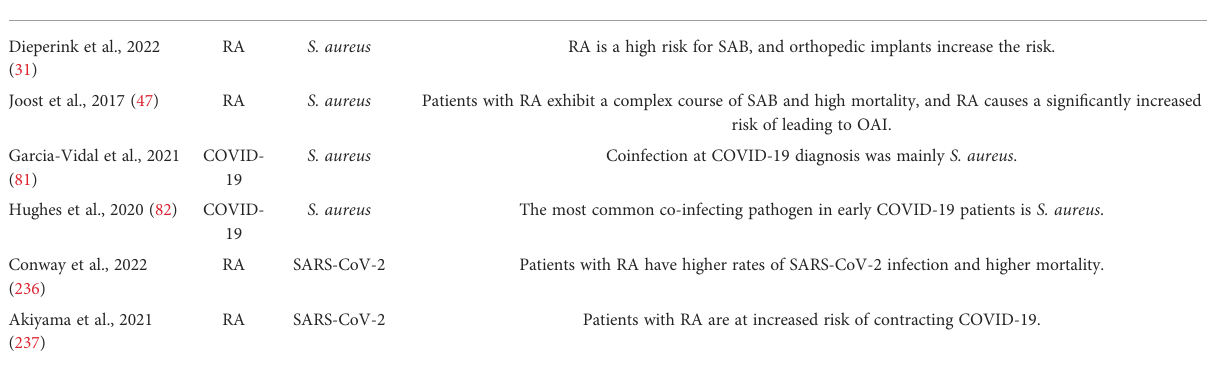
TABLE 5 Literature related to coinfection between RA, SAB, and